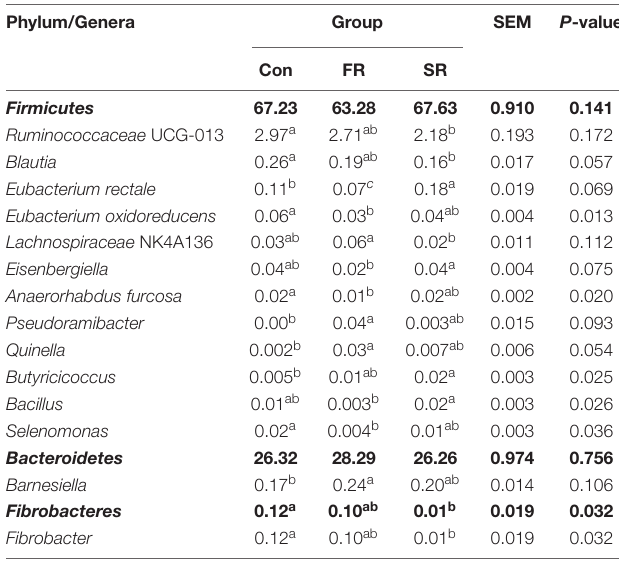
TABLE 1 | Effects of rumen fluid transplantation on fecal microbiota at the phylum and genus level (the relative abundance > 0.01% of all